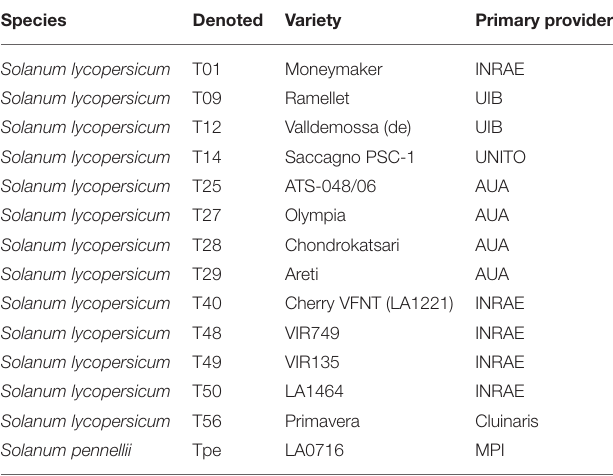
TABLE 1 | Investigated tomato genotypes, denotation, and primary